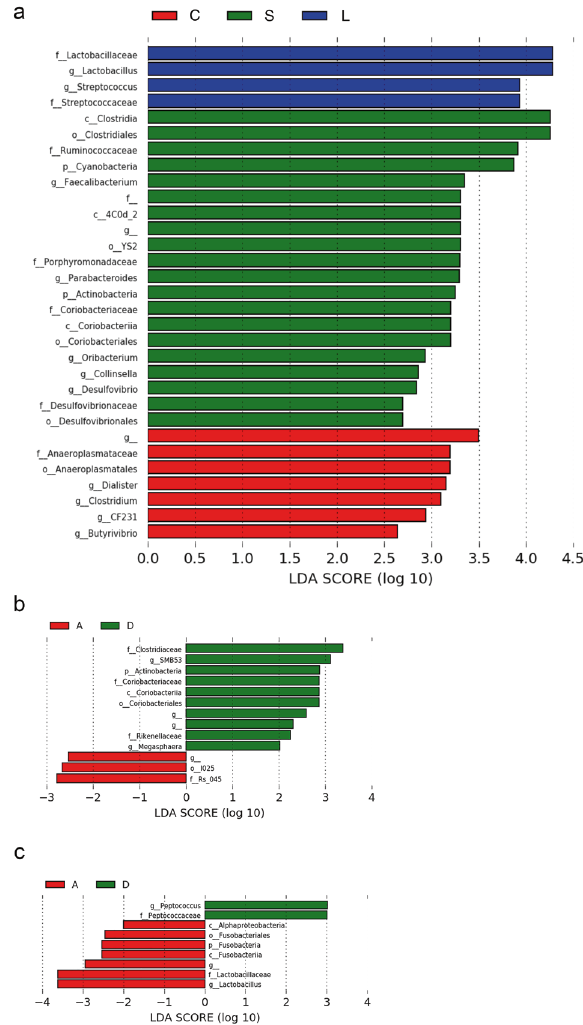
Fig. 4 Effects of chronic excessive alcohol drinking on fecal microbiota composition based on linear discriminating analysis (LDA) effect size (LEfSe) results. a LEfSe plot at the last known taxon of fecal microbial samples of the long-term alcohol drinking group (L, in blue) vs. the short-term alcohol drinking group (S, in green) vs. the control group (C, in red). The drinking (D) and abstinence (A) conditions are combined. The bars represent the effect size (LDA) for a particular taxon in a certain group of baboons. The length of the bar represents a log10 transformed LDA score. The colors represent the group in which that taxon was found to be more abundant compared to the other groups. f_ indicates that the operational taxonomic unit (OTU) was not able to be classi fi ed to a family. g_ indicates that the OTU was not able to be classi fi ed to a genus. b LEfSe plot at the last known taxon of fecal microbial samples of drinking (D, in green) vs. abstinent (A, in red) baboons in group L. The bars represent the effect size (LDA) for a particular taxon in a certain condition. The length of the bar represents a log10 transformed LDA score. The colors represent the condition in which that taxon was found to be more abundant compared to the other condition. g_ indicates that the OTU was not able to be classi fi ed to a genus. c LEfSe plot at the last known taxon of fecal microbial samples of drinking (D, in green) vs. abstinent (A, in red) baboons in group S. The bars represent the effect size (LDA) for a particular taxon in a certain condition. The length of the bar represents a log10 transformed LDA score. The colors represent the condition in which that taxon was found to be more abundant compared to the other condition. g_ indicates that the OTU was not able to be classi fi ed to a